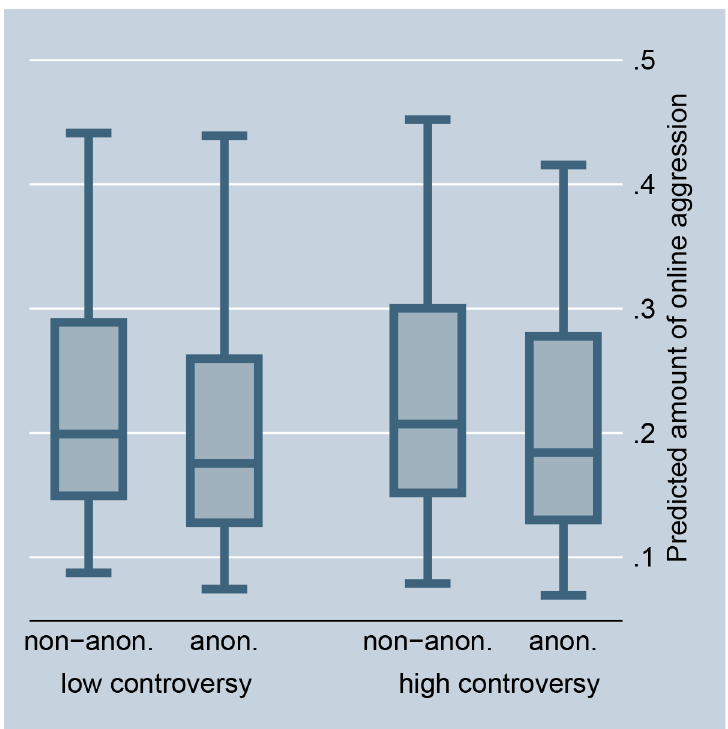
Fig 2. Online aggression dependent on controversy and anonymity (random-effects). Predictions of Table 1, Model